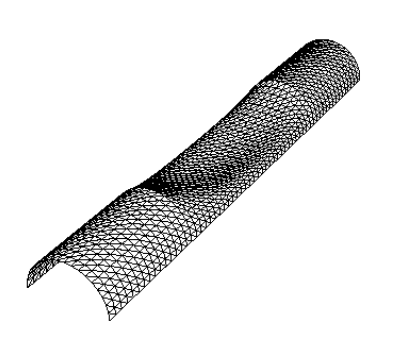
Figure 8. The stenosis